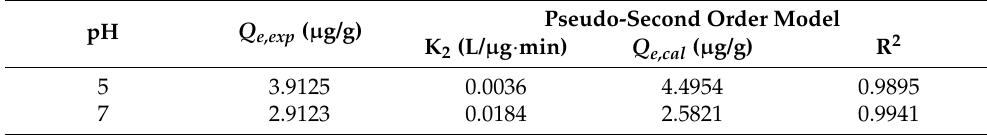
Table 4. Pseudo-second order Kinetics parameters for Cr(VI) adsorption on COC-AC-La.